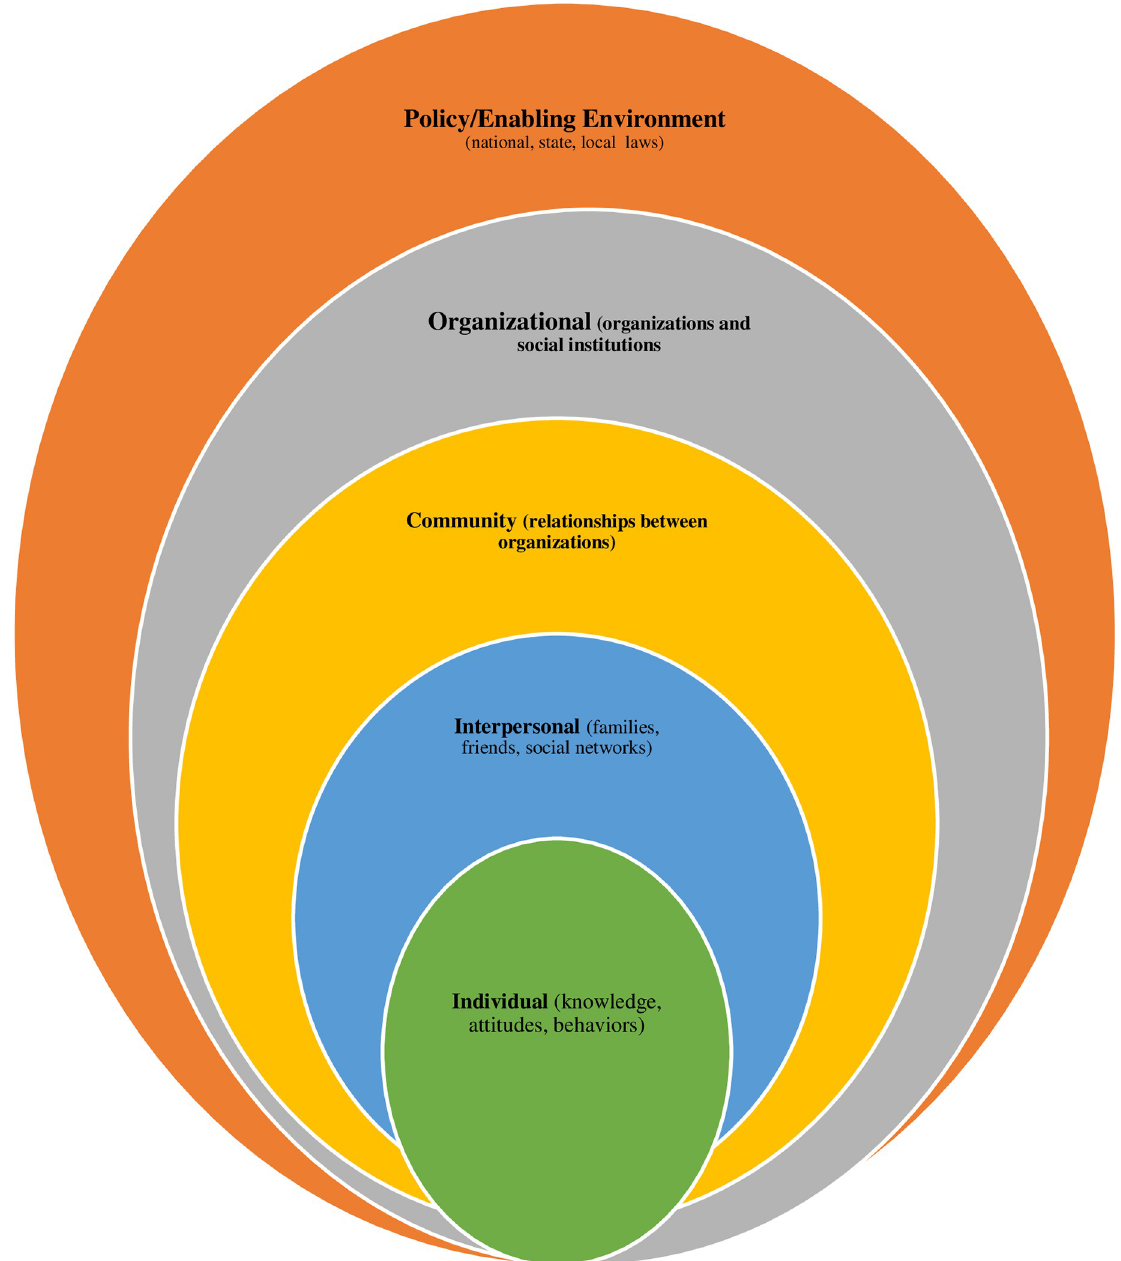
Fig 1. Socio-ecological